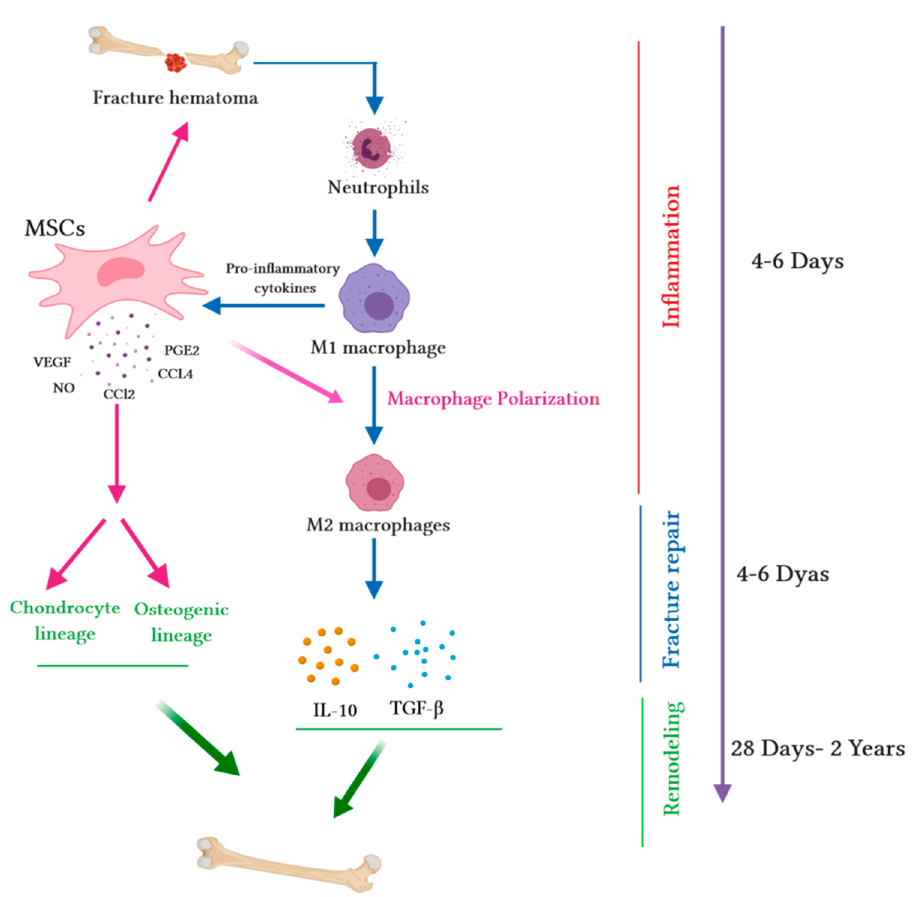
Figure 1. Immunomodulatory capacity of mesenchymal stem cells (MSCs) during the bone healing process. Upon fracture, a hematoma is created, and damaged blood vessels form a clot. Fracture hematoma boosts innate and adaptive immunity, especially neutrophils, resulting in the activation of macrophages. Activated M1 macrophages release pro-inflammatory cytokines and promote the migration of MSCs into hematoma. MSCs release several chemokines (chemokine ligand-2 (CCL2) and chemokine ligand-4 (CCL4)) to recruit monocytes and macrophages. Pro-inflammatory cytokines (tumor necrosis factor alpha (TNF- α ), interleukin-1 alpha (IL-1 α ), or interleukin-1 beta